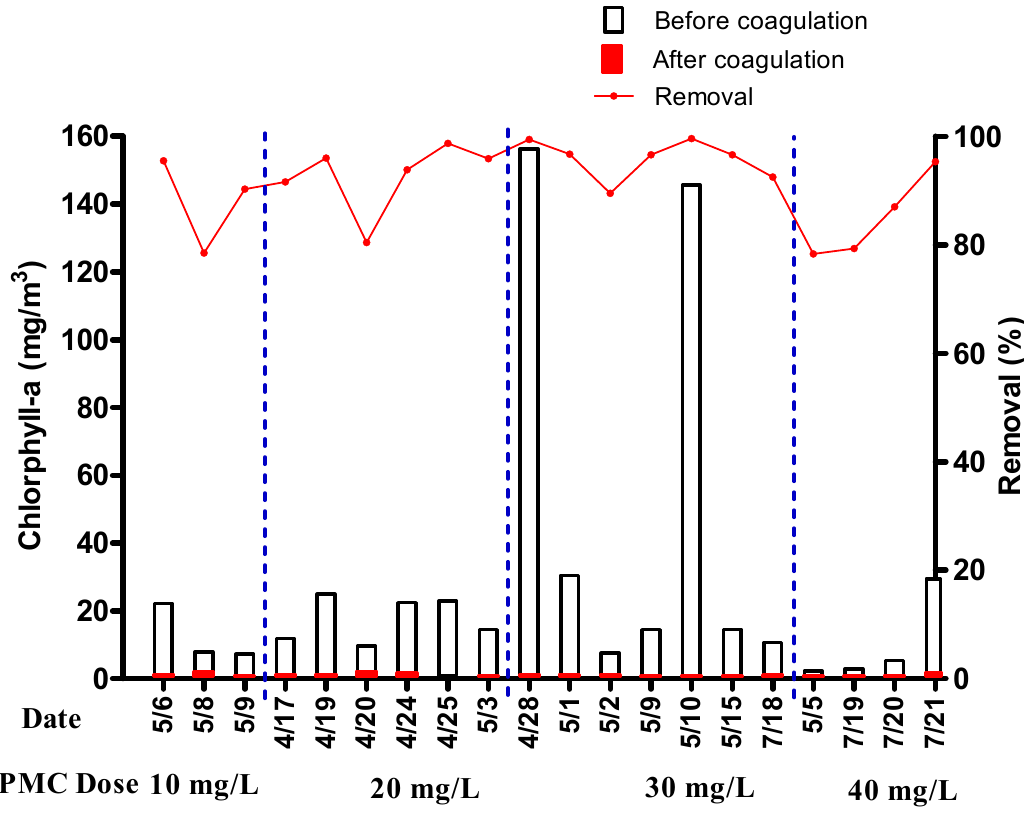
Figure 8. Concentrations of chlorophyll-a before and after coagulation using the PMC-based in the pilot-scale tests (PMC dose: 10, 20, 30, and 40 coagulant in the pilot-scale tests (PMC dose: 10, 20, 30, and 40 mg/L).